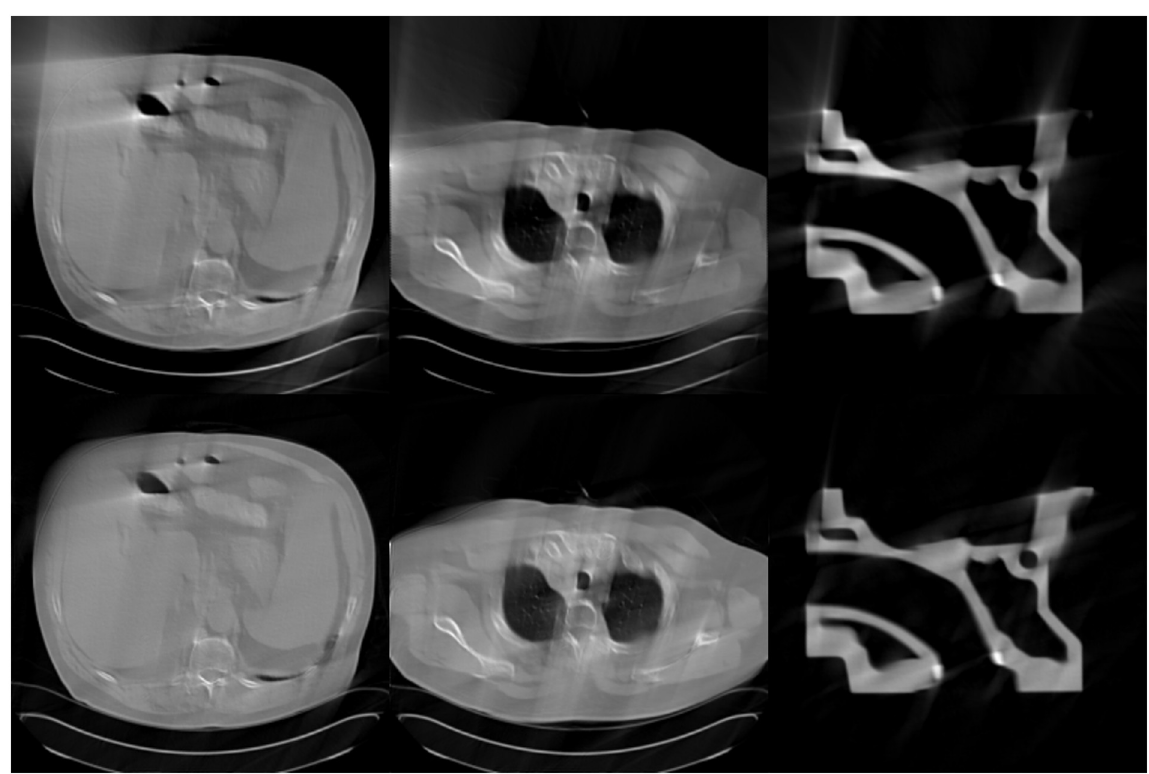
Fig 4. Reconstruction results for the scanning range [0˚, 120˚]. The first row is the images reconstructed by the FBP method, and the second row is the images reconstructed by the SART